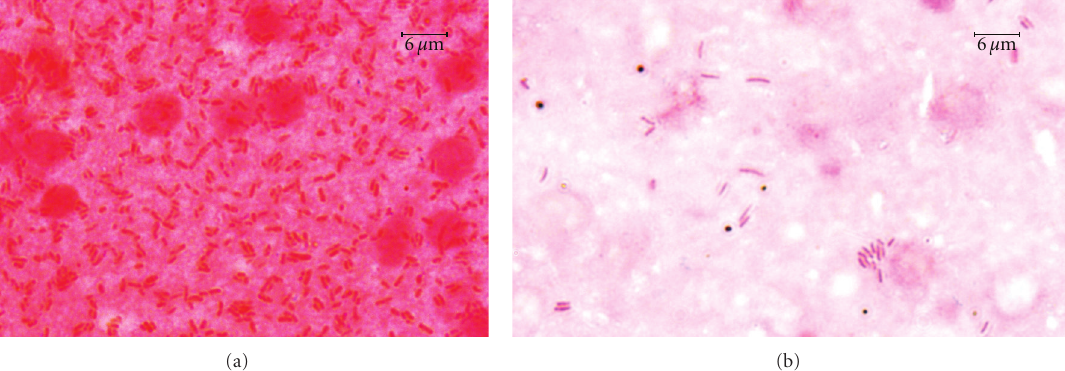
Figure 7: Numerous bacterial cells of A. hydrophila strain Pt104 (a) adhering to trout liver (a) and isolated bacterial cells of A. sobria strain K24 adhering to carp kidney (b).